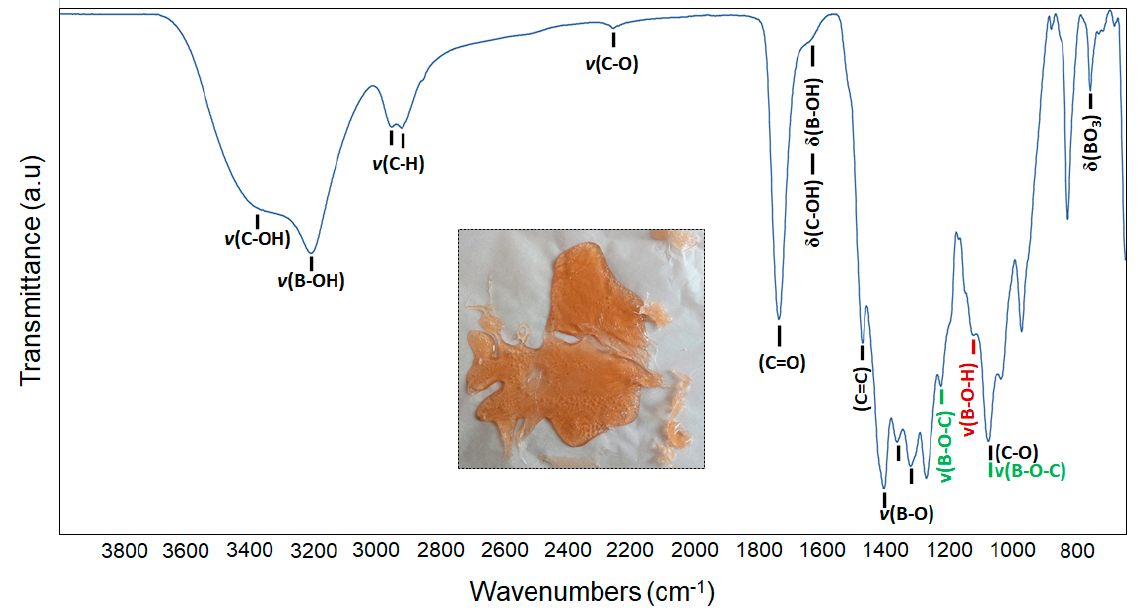
Figure 1. FT-IR spectra of the polyol-based condensed gel and its photograph (inset) taken at room temperature.